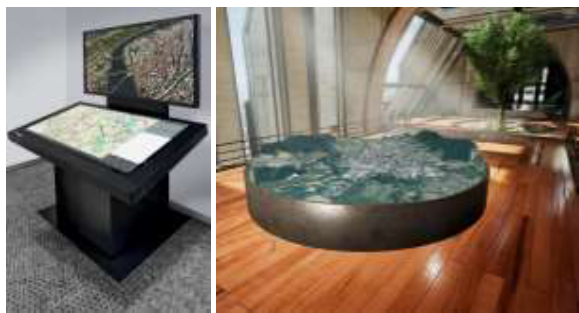
Figure 7: Output options of the DigLT